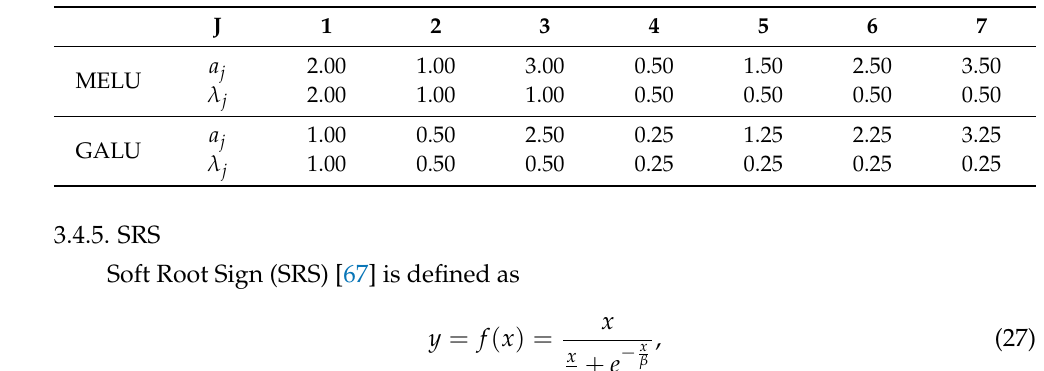
Table 2. Comparison of the fixed parameters of GaLU and MeLU with maxInput =